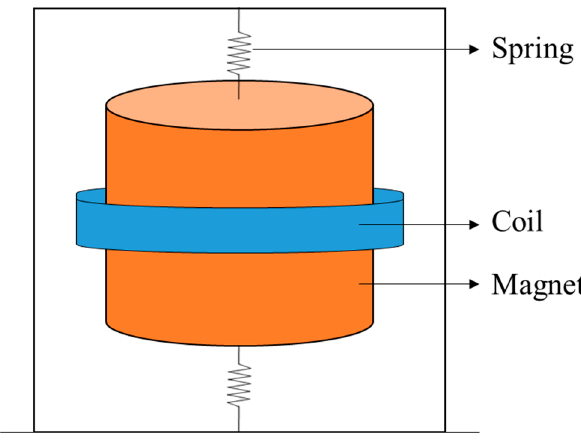
Figure 5. Geophone functioning principle.